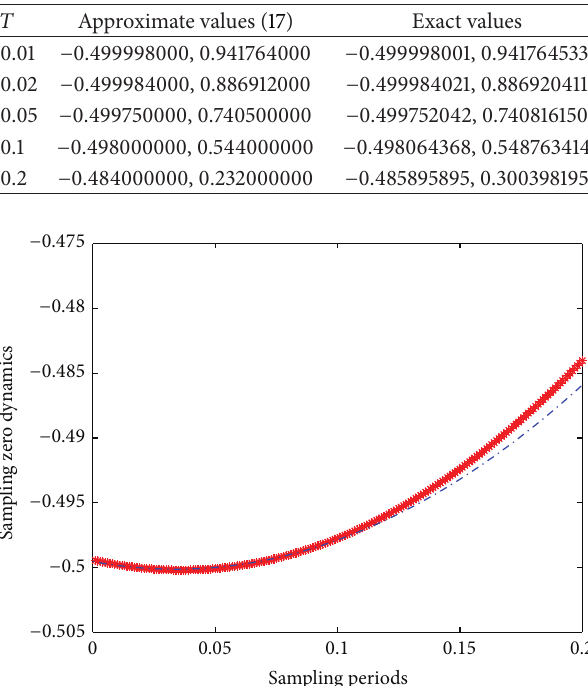
Table 1: Zero dynamics of the discrete-time model with time delay and relative degree two.